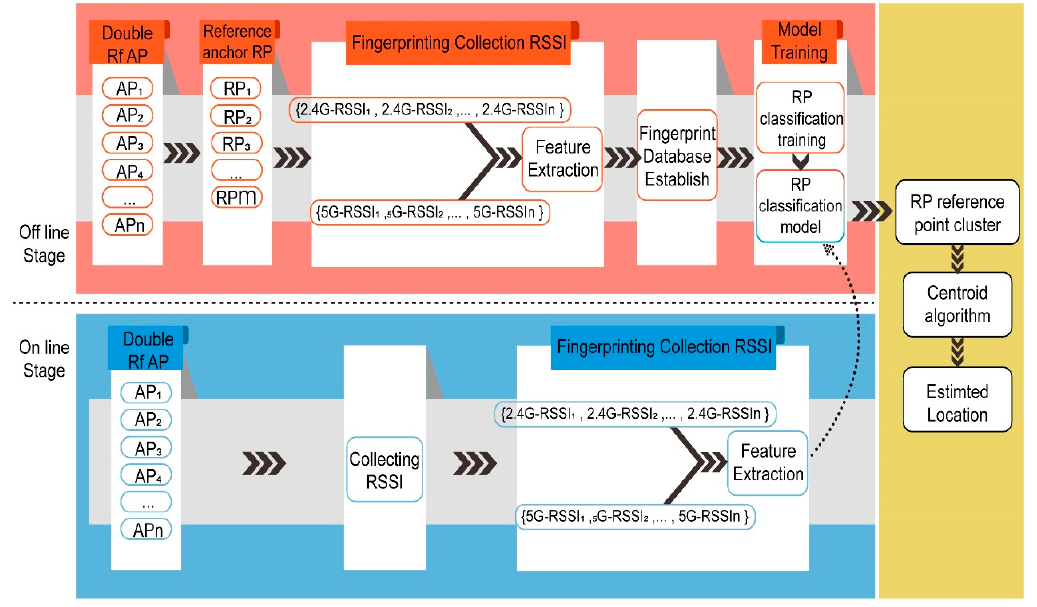
Figure 5. The schematic diagram of the hybrid dual frequency received signal strength indicator (HDRF-RSSI) fingerprint location method.